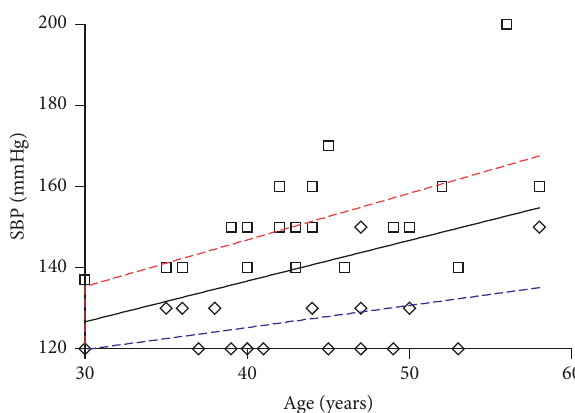
Figure 3: Comparison of regression plots of systolic blood pressure (SBP) and age in prehypertensive (blue dashed line), hypertensive (red dashed line), and all participants (black solid line) aged < 60 years in the study cohort. Comparison of slopes: 𝑡 = 0.235 , 𝑝 = 0.816 ; comparison of intercepts: 𝑡 = 0.002 , 𝑝 = 0.999 ; test of coincidence, 𝐹 = 25.365 𝑝 < 0.0001